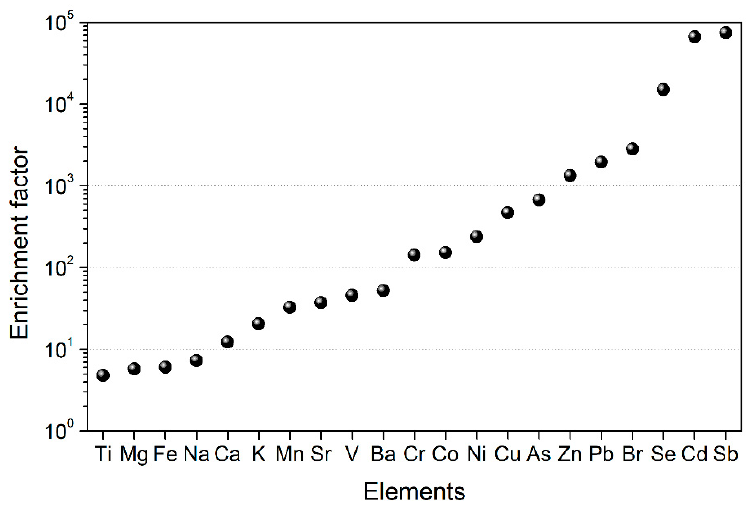
Figure 4. Enrichment factors (EFs) of 21 trace elements relative to Al for the PM 2.5 samples.